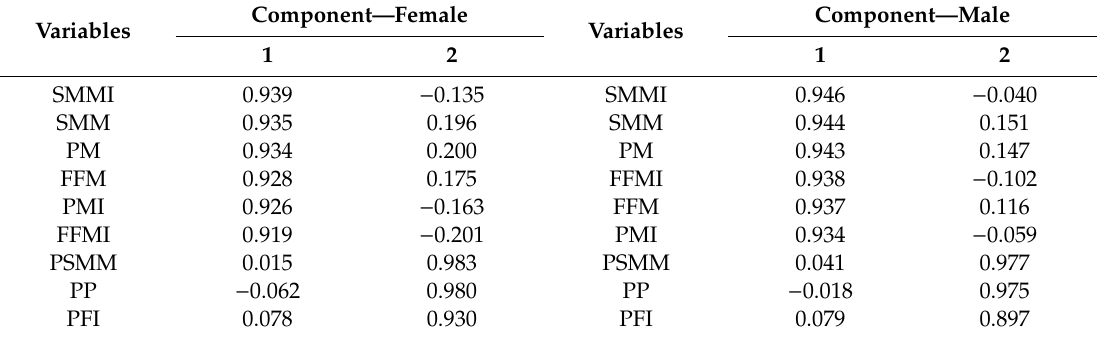
Table 3. Structure matrix extracted according to the gender.